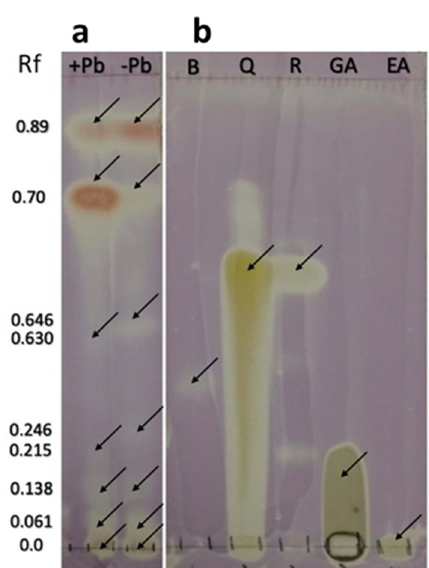
Figure 9. DPPH bioautography of strain H17’s extracts developed in chloroform:methanol (5:1 v/v). ( a ) Extracts from cultures in presence ( + Pb) or absence ( − Pb) of lead. ( b ) Reference standards: Boshnaloside (B), Quercetin (Q), Resveratrol (R), Gallic acid (GA), Ellagic acid (EA).